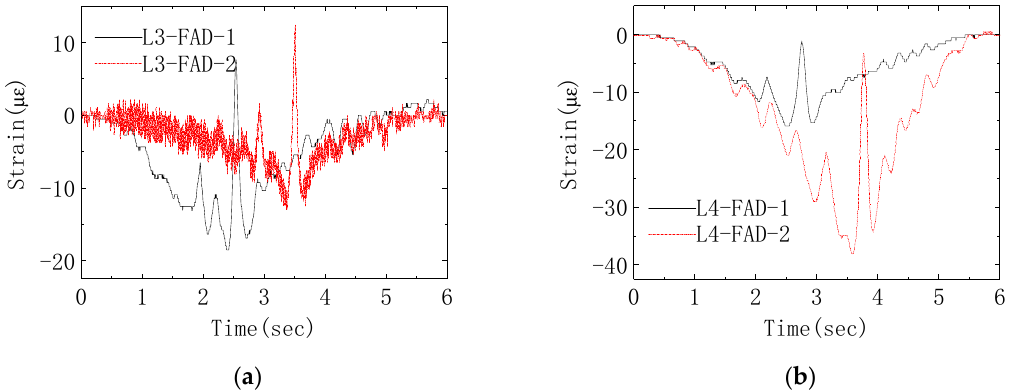
Figure 13. Raw FAD signals for multiple presence loading event: ( a ) Truck B in Lane 3; ( b ) Truck A in Lane 4.